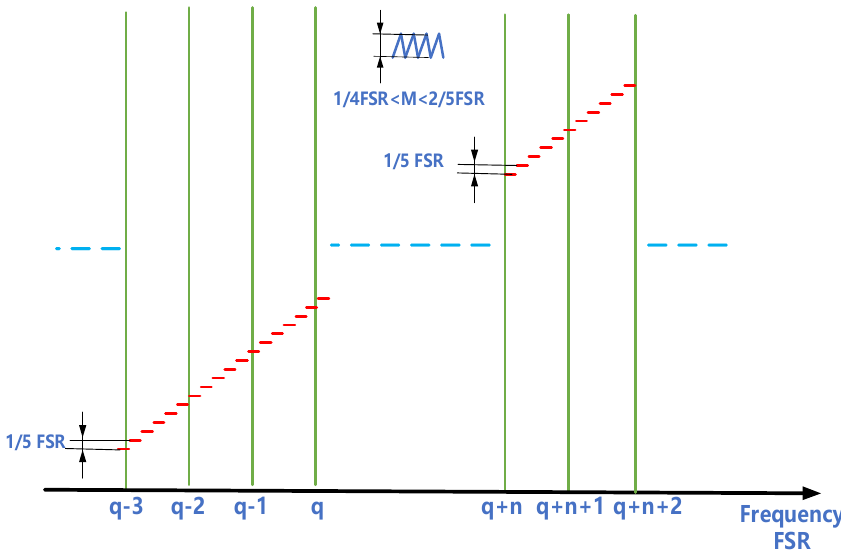
Figure 5. Schematic of the stepwise spectral scanning.